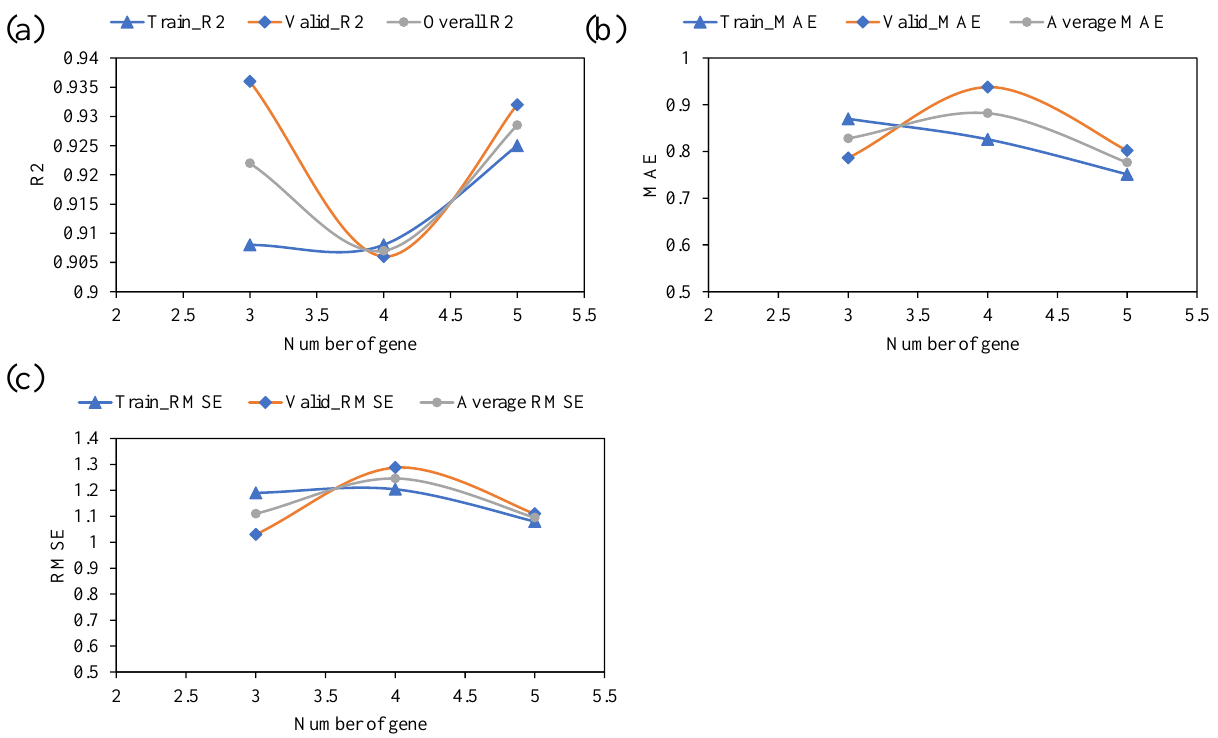
Figure 7. Effect of number of genes on the performance of the models: ( a ) R 2 , ( b ) MAE, and ( c ) RMSE.